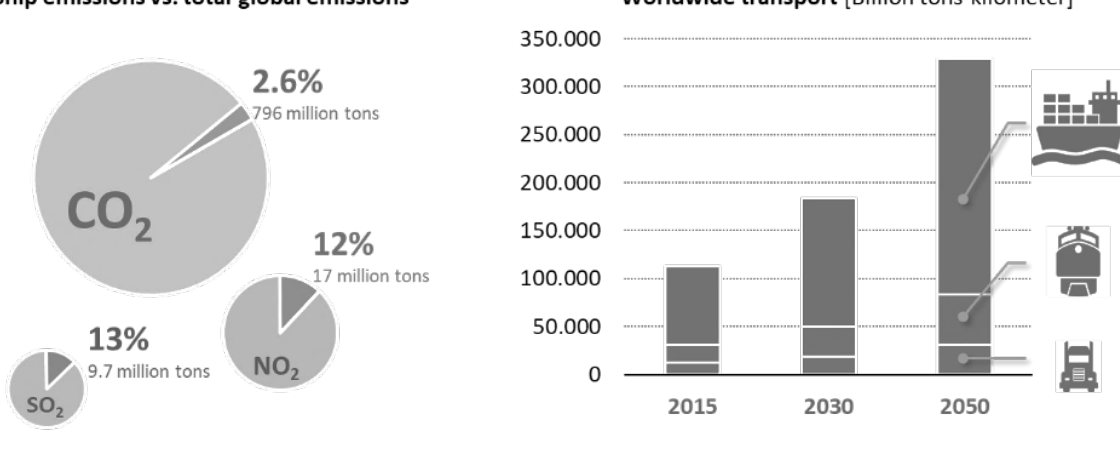
Figure 1. Emissions and development of global transport